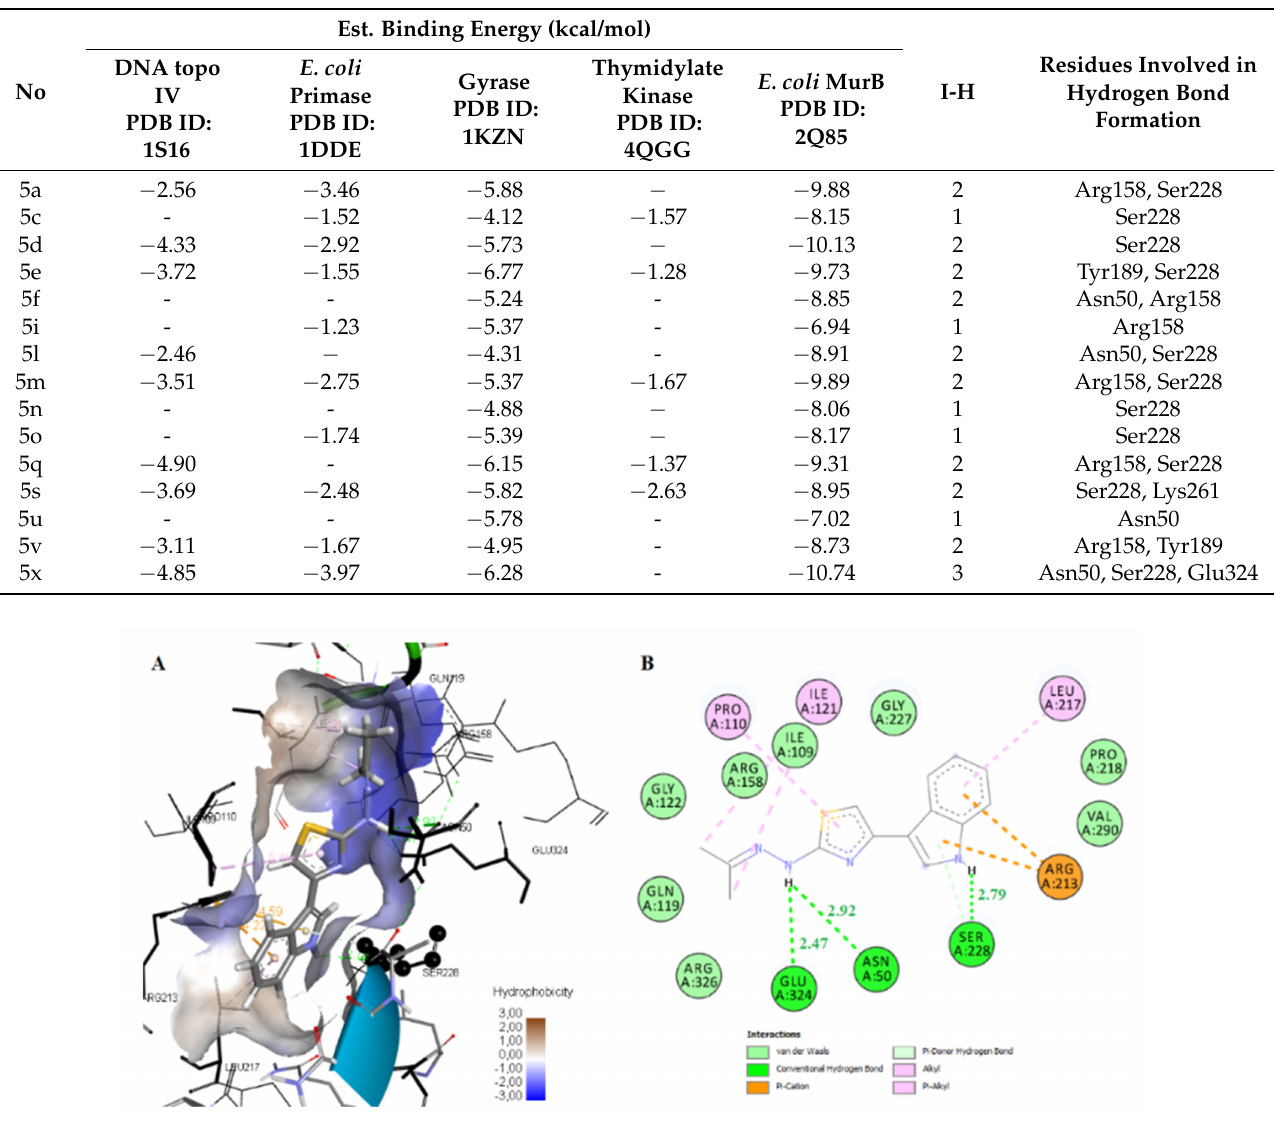
Figure 5. Binding mode in 3D ( A ) and 2D ( B ) of compound 5x into the enzyme-active side of E. coli MurB (PBD: 2Q85). Green dotted lines represent the hydrogen bonds; pink-colored dotted lines and light green spheres represent pi-pi and hydrophobic interactions,